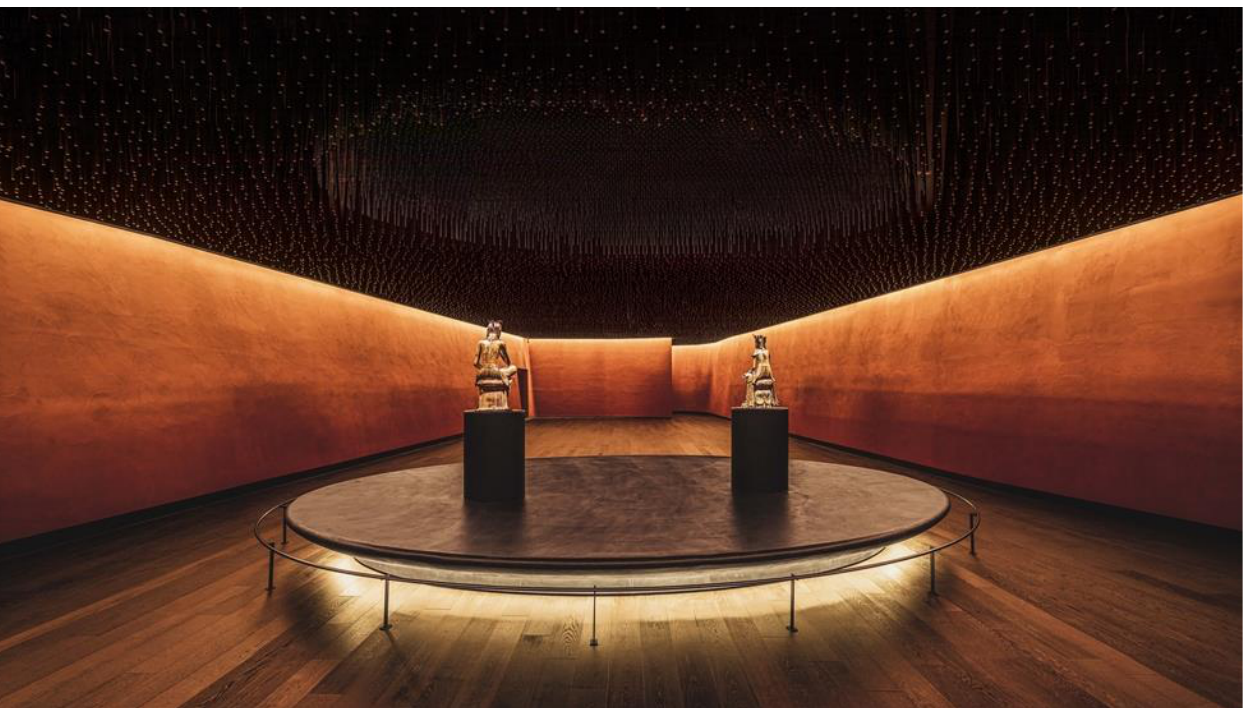
Figure 9. View from the entrance unto “A Room of Quiet Contemplation”. Photos from The Korean JoongAng Daily, 1 February 2022. Photos in public domain.